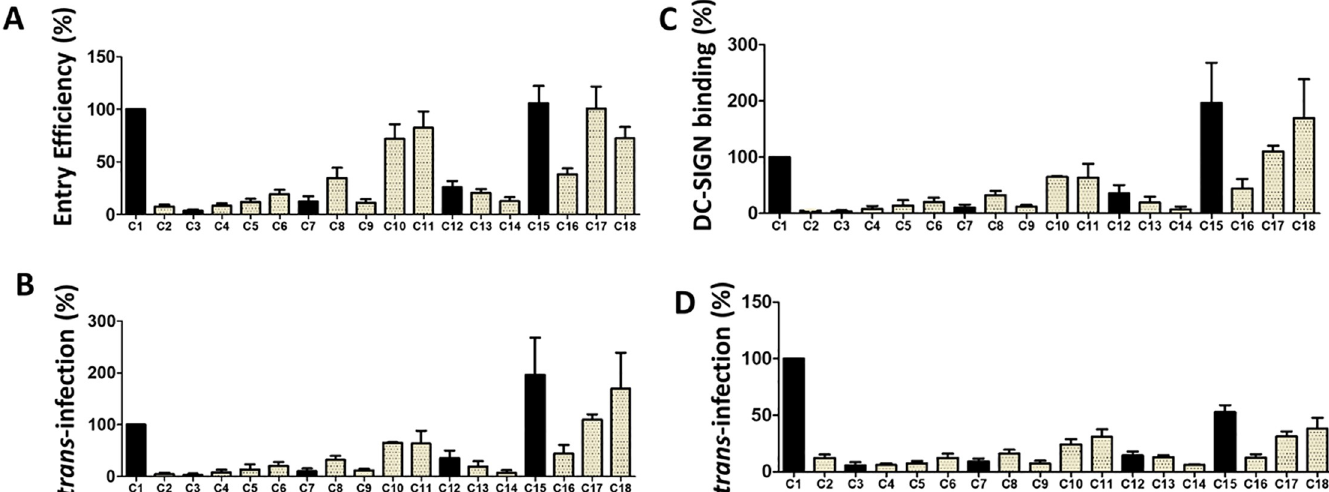
Fig 1. Characterisation of Envelope phenotype. A) Pseudovirus (PSV) equivalent to 100 ng ml − 1 p24 were compared for their ability to enter TZM-bl cells. Entry was monitored through the activation of a luciferase reporter gene under the control of the LTR. The bar graphs are means of four biological repeats with error bars showing standard error of the mean (SEM). Statistical analysis of the medians was done using Mann Whitney two tailed comparison. B) PSV equivalent to 10 ng p24 were bound to Raji-DC-SIGN cells and after washing the cells, bound PSV was detected by p24 ELISA and normalized to input PSV. Mean and SEM of two biological repeats are indicated. C) Raji-DC-SIGN cells or D) monocyte derived dendritic cells (MDDCs) were used to trans -infect TZM-bl cells. The averages of two C) and four D) independent repeats with SEM are indicated. To compare data across biological repeats, all raw values are indicated as a percentage of C1.